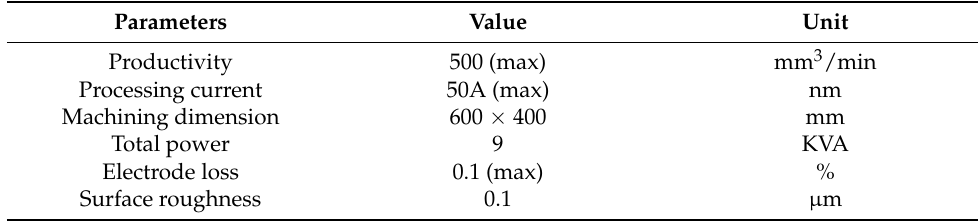
Table 1. Specific parameters of electric-spark equipment. Figure 1. Electrode for preparing texture.